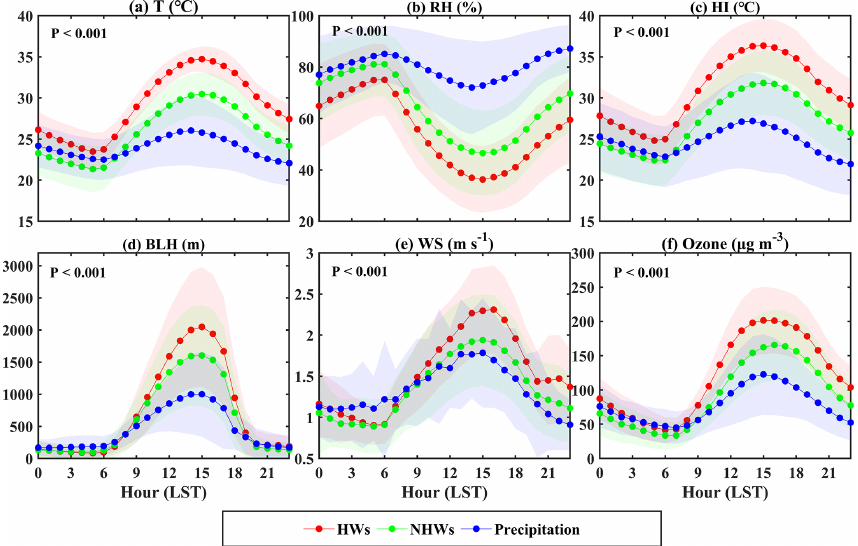
Figure 5. The diurnal variation of (a) air temperature, (b) RH, (c) HI, (d) BLH, (e) WS, and (f) O 3 , under HW, NHW, and precipitation periods (shading indicates standard deviation; P < 0 . 001 shows statistical